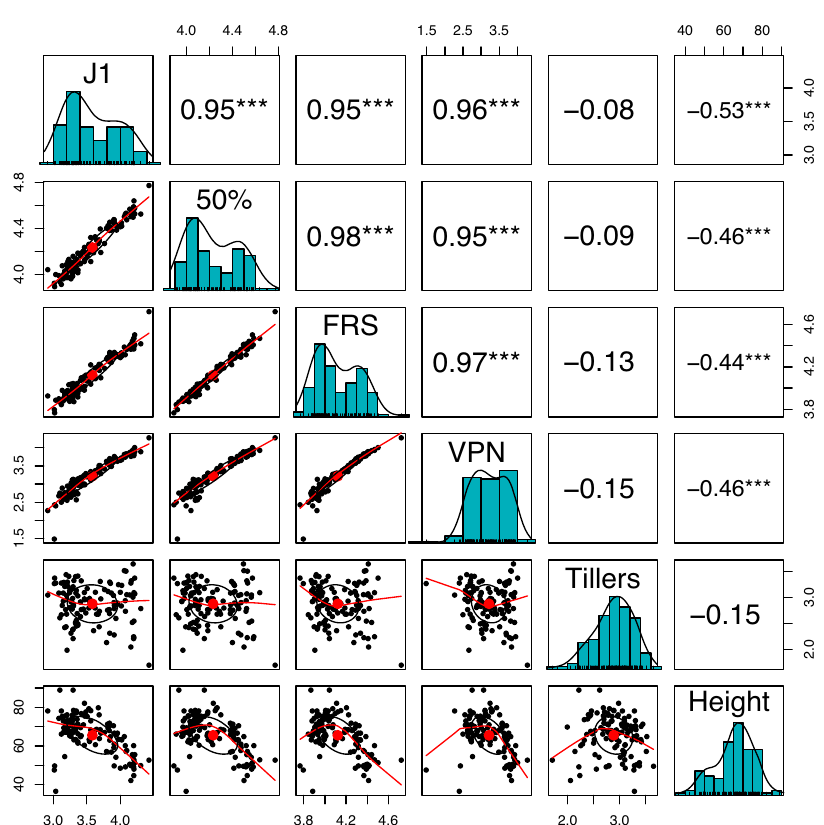
Fig. 2 Distributions, Spearman correlations, and scatter plots of the genotype BLUEs for height (cm), number of tillers, days until fi rst panicle (VPN), days until 50% rip seed (50%), days until fi rst joint (J1), days until fi rst ripe seed (FRS) used in the GWAS analysis. Histograms with density ticks and a smoothing line are on the diagonals. The upper diagonal contains the Spearman correlation between BLUEs of traits with “ *** ” denoting a signi fi cant level ( p < 0.0001) of correlation between traits, where N = 121 genotypes. The lower diagonal contains scatter plots between traits with center dot, a centroid with a standard deviation of 1 and locally estimated scatterplot smoothing (LOESS) smoothing curve. Table 1 Description of the variation and consistency of phenotypic data across lines in greenhouse trials. Trait H 2 BLUE µ BLUE sd BLUE min BLUE max Height 0.96